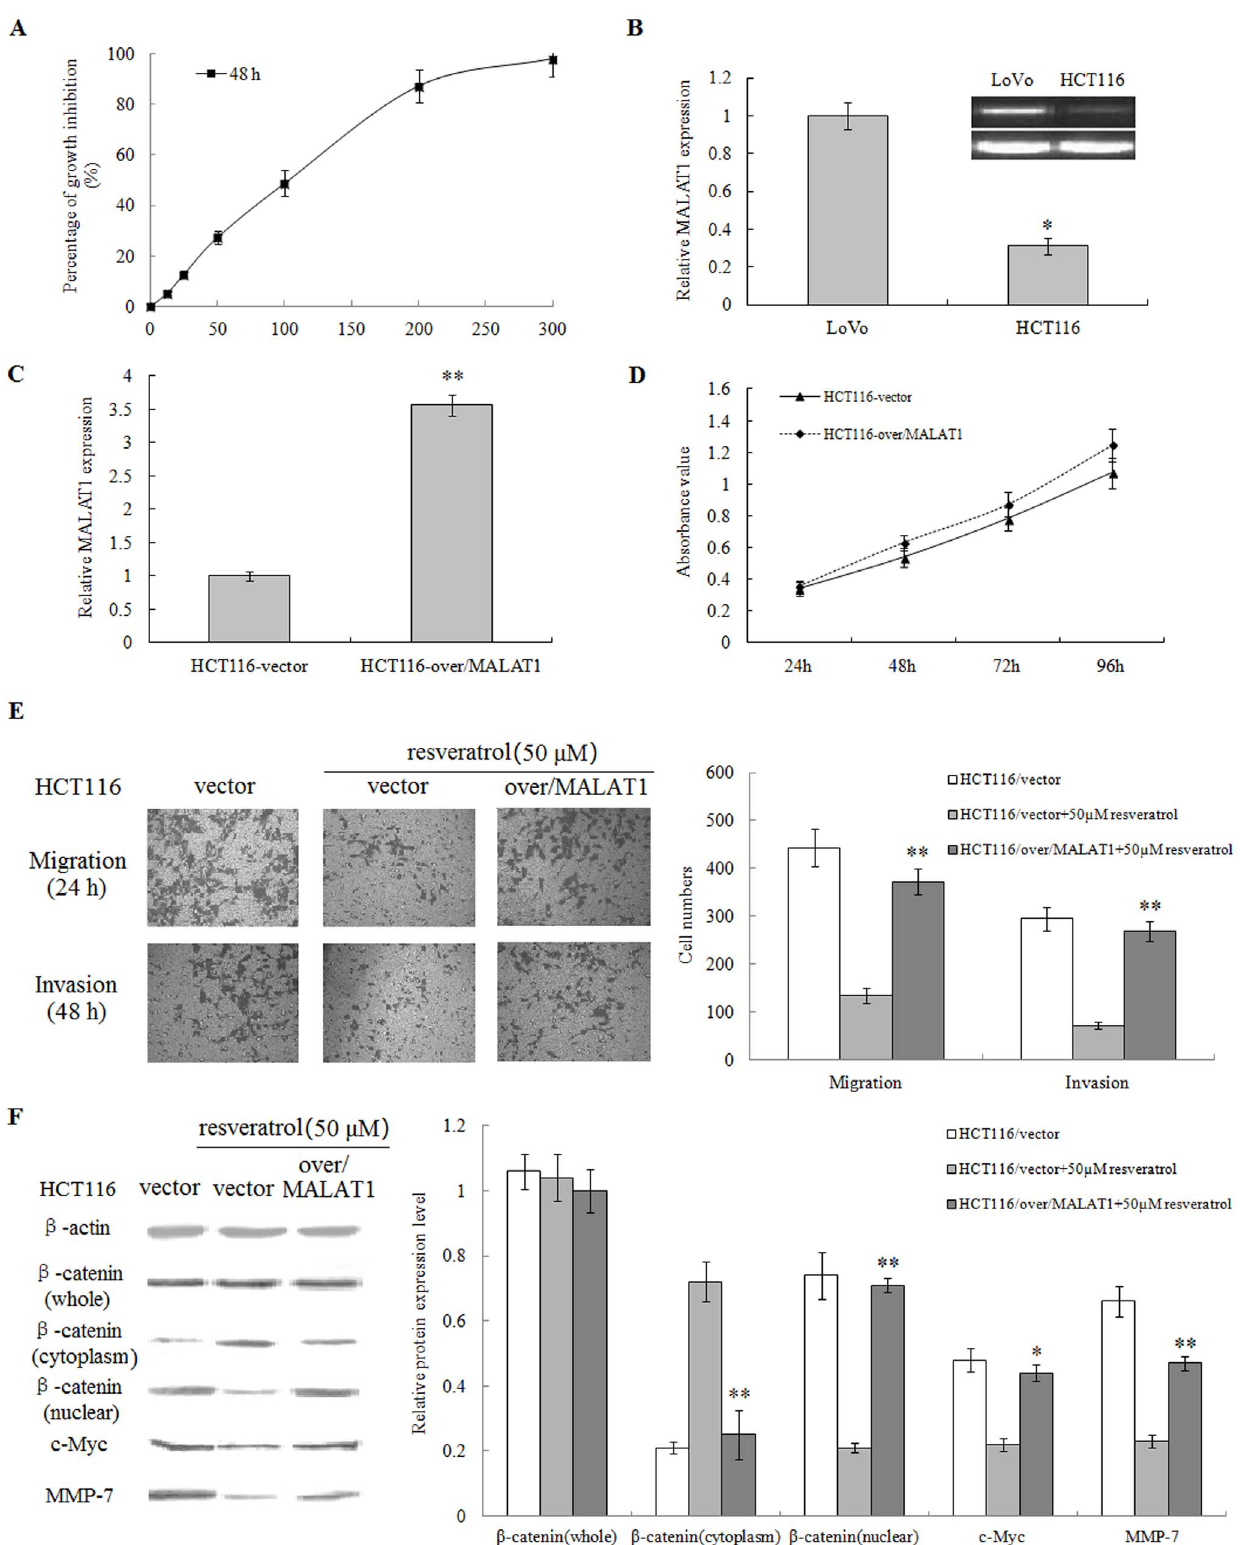
Figure 8. Resveratrol inhibits the Wnt/ b -catenin signaling through regulating MALAT1.in CRC HCT116 cells. (A): Resveratrol inhibited the proliferation of HCT116 cells with an IC50 of 100 m M. (B): HCT 116 cells showed lower MALAT1 expression than LoVo cells. ** p , 0.01, compared with LoVo cells. (C): Overexpression of MALAT1 in HCT116 cells. (D): Overexpression of MALAT1 promoted the in vitro growth of HCT116 cells. (E): Overexpression of MALAT1 attenuated the suppressive effect of resveratrol on migration and invasion in HCT116 cells. HCT116 cells expressing MALAT1-overexpressed, empty vector were treated with or without 50 m M resveratrol for 48 hours and cellular migration and invasion ability were